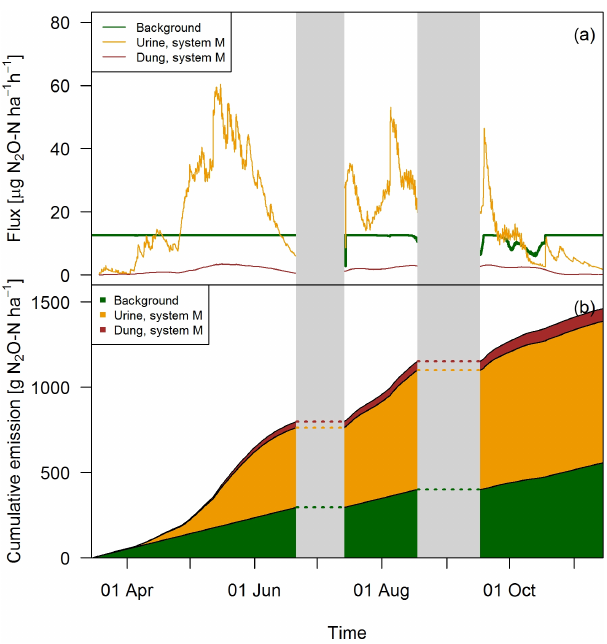
Figure 12. (a) Time series of upscaled FB fluxes averaged over all paddocks of system M for all three emission sources during the grazing season 2016, and (b) retrieved cumulative emission con- tribution of the emission sources to the overall field